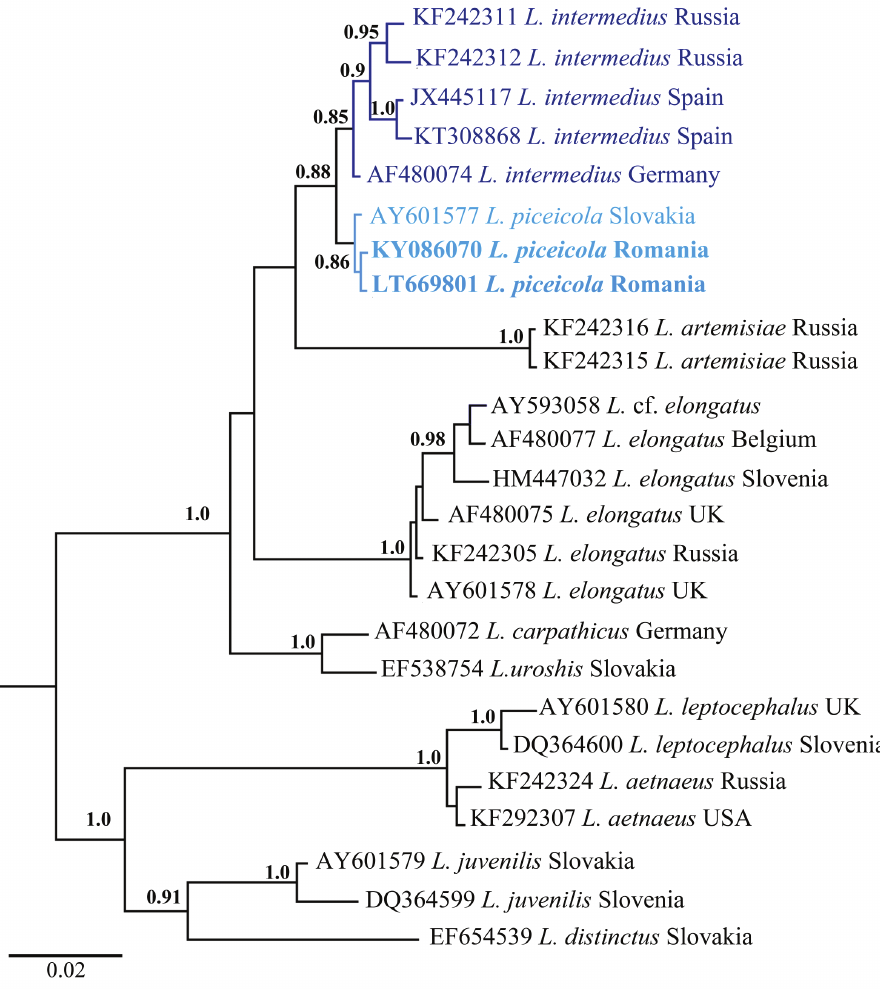
Figure 8. Phylogenetic tree using D2-D3 28S rDNA and inferred from a Bayesian analysis with GTR+G model and midpoint rooting. Posterior probabilities ≥ than 0.8 are